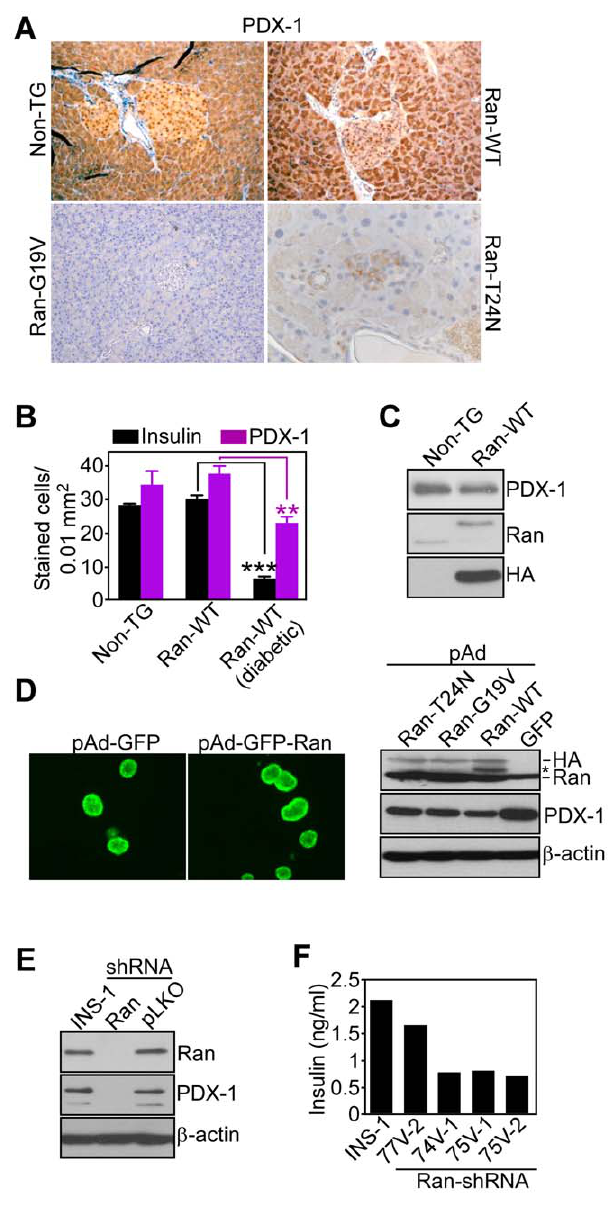
Figure 7. Deregulated PDX-1 expression in Ran-targeted cells. A , Pancreas sections from non-TG, Ran-WT, Ran-G19V or Ran-T24N transgenic mice were stained with an antibody to insulin or PDX-1, by immunohistochemistry. B , The number of insulin- or PDX-1-stained cells was quantified by morphometry in the indicated surface area. Insulin + cells, non-TG (n=2), 28.2 6 0.4; Ran-WT (asymptomatic, n=3), 29.8 6 1.2; Ran-WT (diabetic, n=3), 6.2 6 0.6, ***, p , 0.0001; PDX-1 + cells, Non-TG (n=2), 34.2 6 4.1; Ran-WT (asymptomatic, n=3), 37.5 6 2.3; Ran-WT (diabetic, n=3), 22.8 6 1.8, **, p=0.007. C , Islets from 2 mo-old non-TG or a Ran-WT transgenic mouse were analyzed by Western blotting. D , Pancreatic islets isolated from non-TG mice were transduced ex vivo with control pAd-GFP or pAd-GFP-Ran-WT, pAd-GFP-Ran-G19V or pAd- GFP-T24N and analyzed after 48 h by fluorescence microscopy for GFP expression ( left ), or Western blotting ( right ). *, non-specific. E , INS-1 cells were left untreated (INS-1) or transduced with control lentivirus (pLKO) or lentivirus encoding Ran-directed shRNA (Ran, 74V1), and analyzed by Western blotting. F , Parental INS-1 cells or four independent clones of INS-1 cells stably transduced with Ran-directed shRNA (77V-2, 74V-1, 75V-1, 75V-2) were analyzed for changes in insulin release in the supernatant. Representative experiment out of at least two indepen- dent determinations.